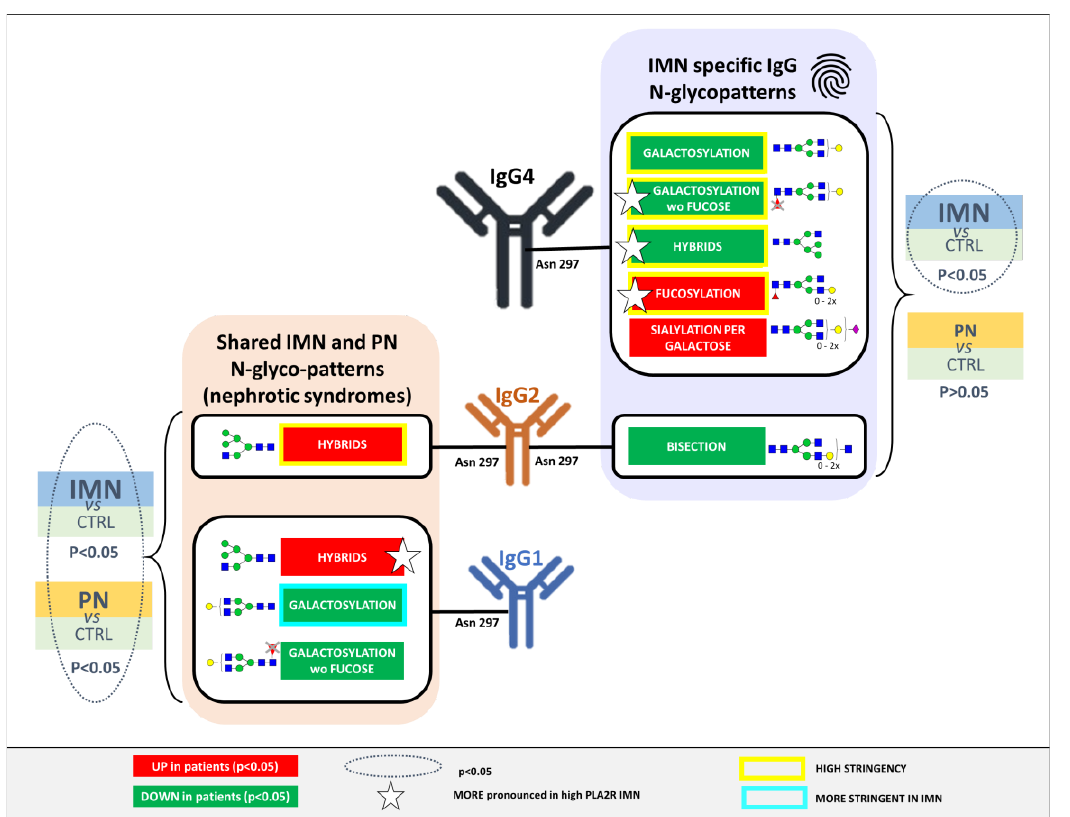
Figure 6. Illustration of the significant N -glycan signatures of serum IgG1, 2, and 4 associated specifically to IMN or both IMN and pathological controls. Features indicated with a star were more pronounced in high PLA2R Ab titer IMN patients. The stringency (yellow/blue box) refers to the significance considering both matching approaches.